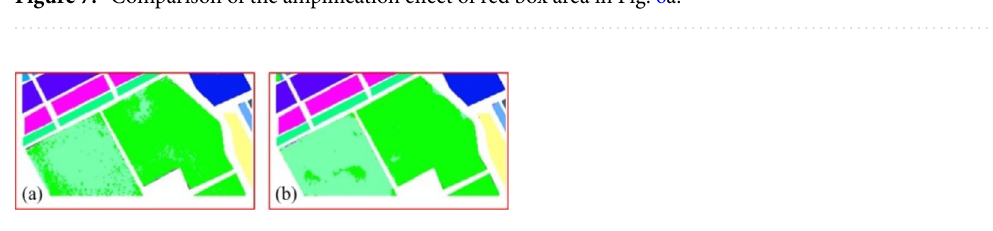
Figure 8. Comparison of the amplification effect of red box area in Fig.